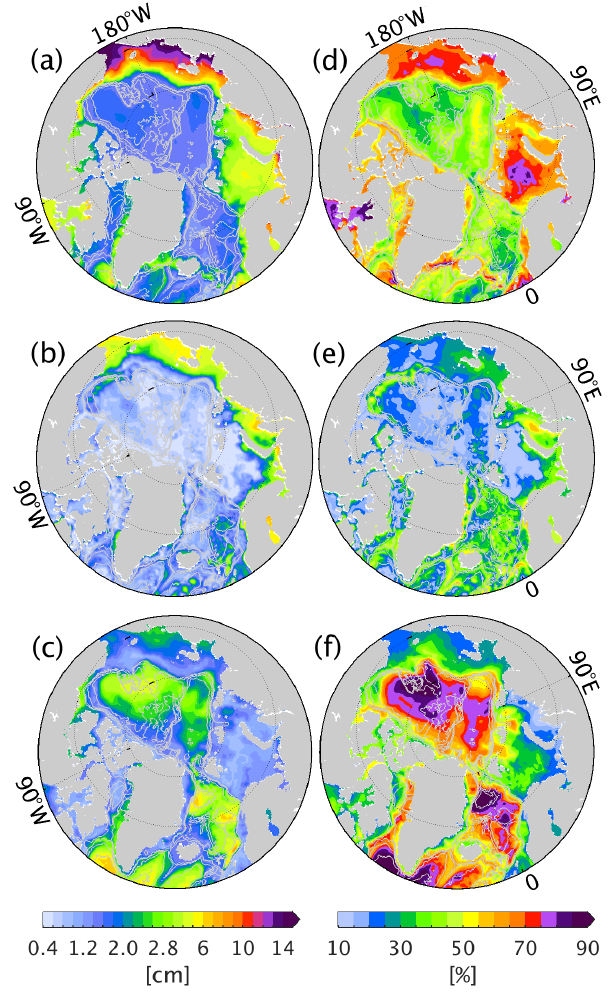
Figure 4. The rms variability (cm) of sea level (a) in the high- frequency band ( < 30d), (b) at the seasonal cycle, and (c) at decadal periods ( > 4 years). Panels (d) – (f) are the corresponding ra- tios (%) to the total sea level variance that panels (a) – (c) explained. The high-frequency and seasonal variability (a, b, d, e) uses the daily output of ATLARC04km, and decadal variability (c, f) uses the monthly output from ATLARC08km. The gray lines denote bathymetry contours of 500, 1000, 2000, and 3000m.